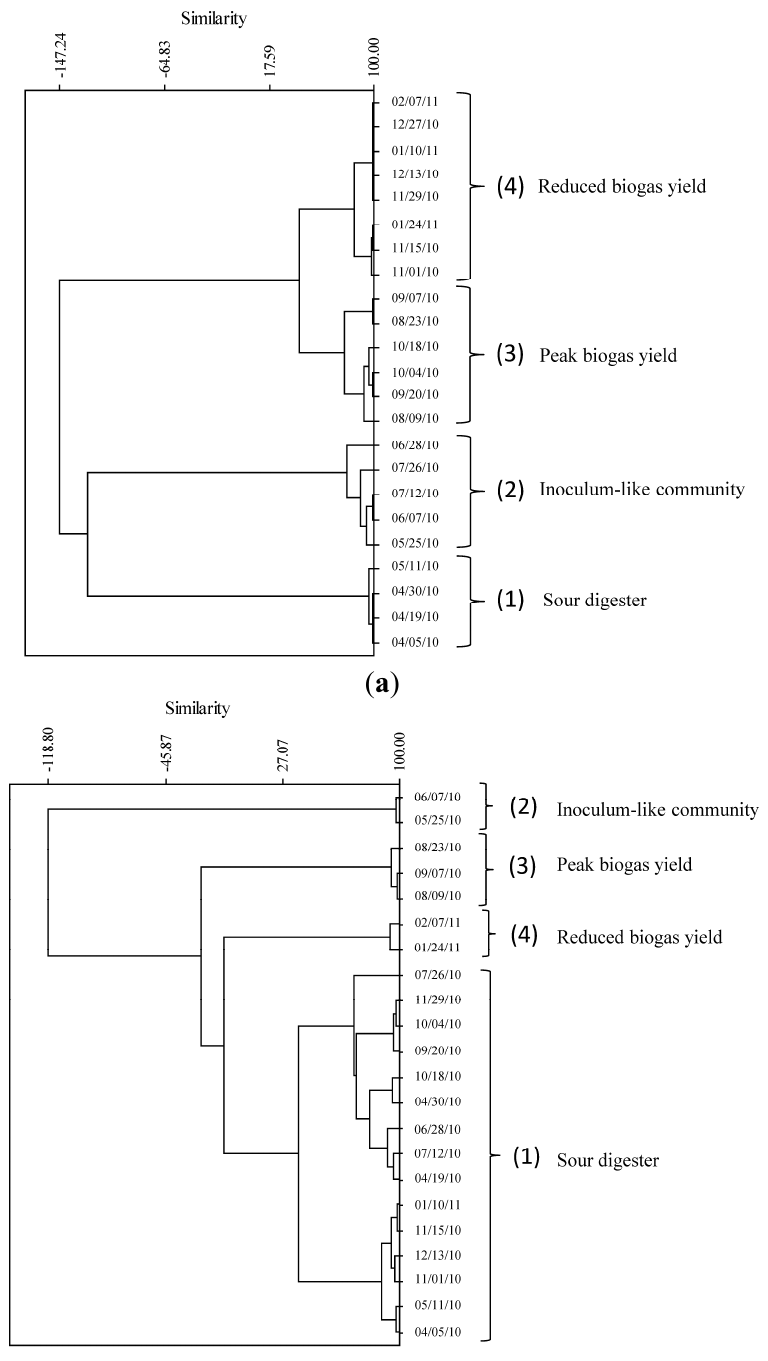
Figure 1. Cluster dendrogram (Ward linkage, squared Euclidean distance) for the dominant Archaeal ( a ) and Bacterial ( b )